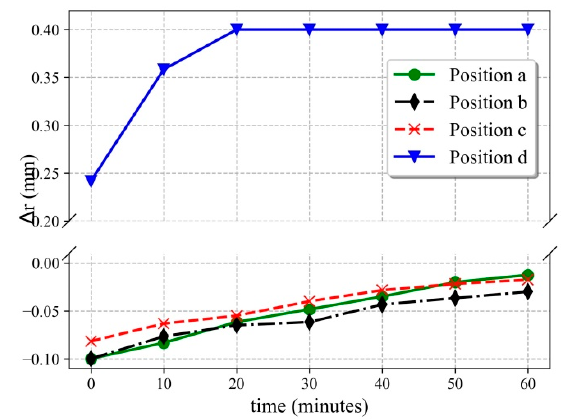
Figure 5. Changes in the radius of the piston at di ff erent positions versus time after removing it from the